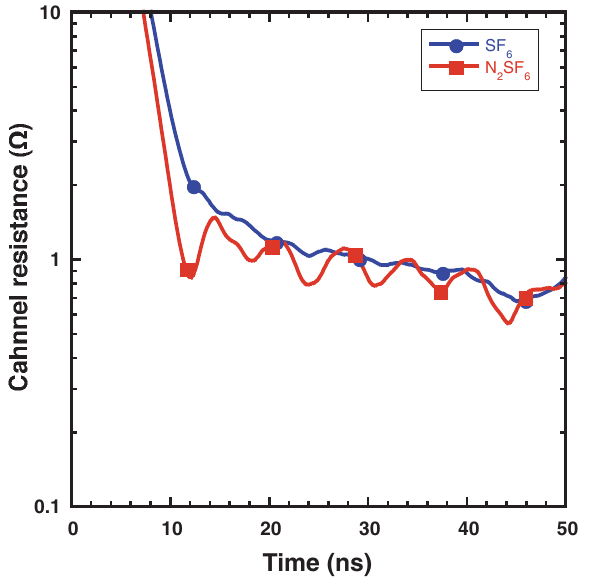
FIG. 7. (Color) Arc channel resistance for pure sulfur hexafluo- ride and 90% nitrogen-10% sulfur hexafluoride